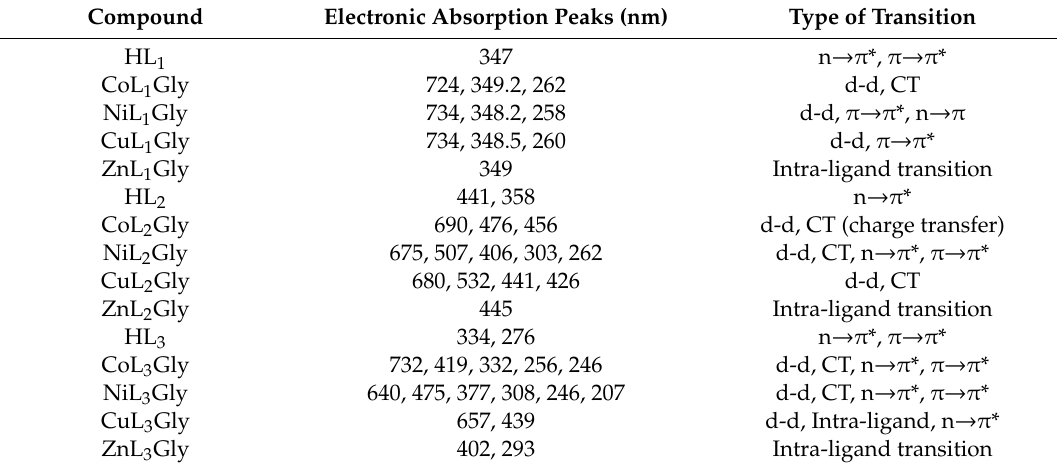
Table 1. Electronic spectral data of ligands (HL 1–3 ) and heteroleptic complexes (ML 1–3